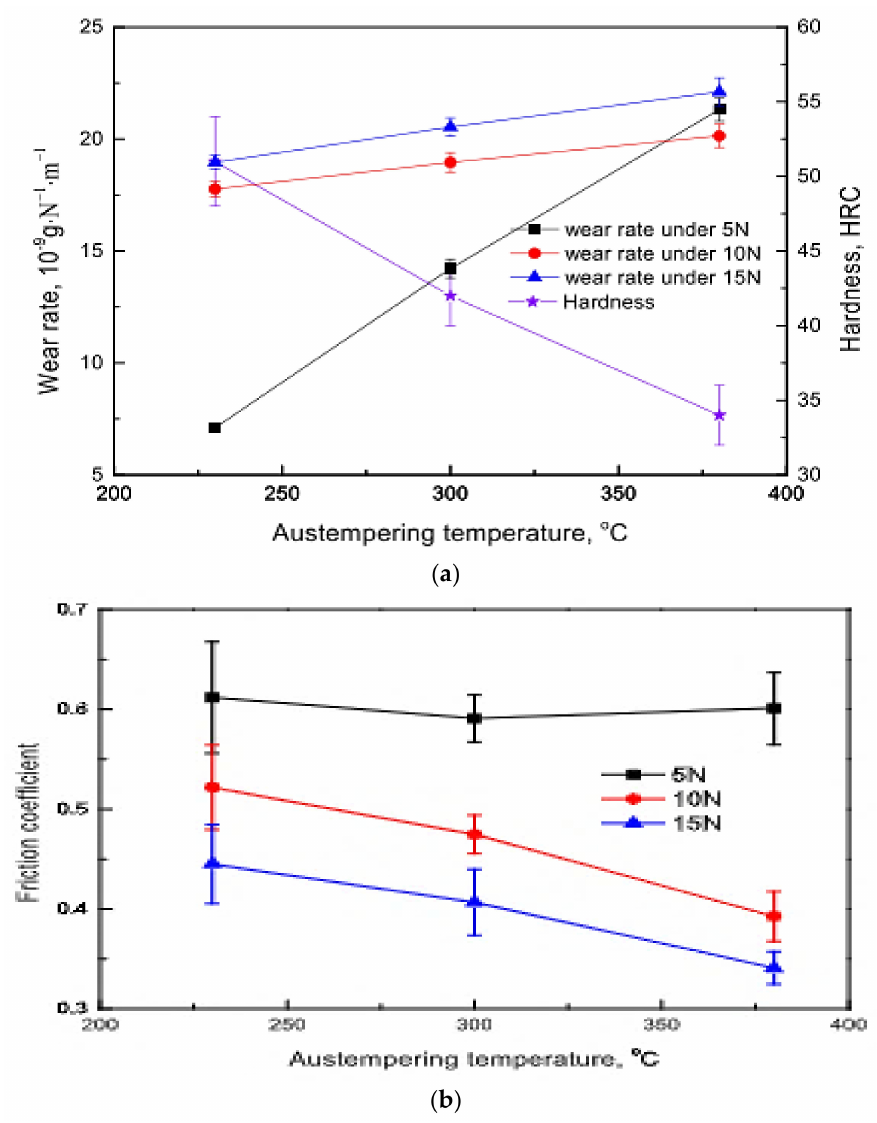
Figure 30. ( a ) The wearing and hardness of ADI ranges with austempering temperature under varying forces [39]. ( b ) The ranges of coefficient of friction of samples vs austempering temperature [39]. The morphology of the worn surface after it dried was examined (Figure 31).